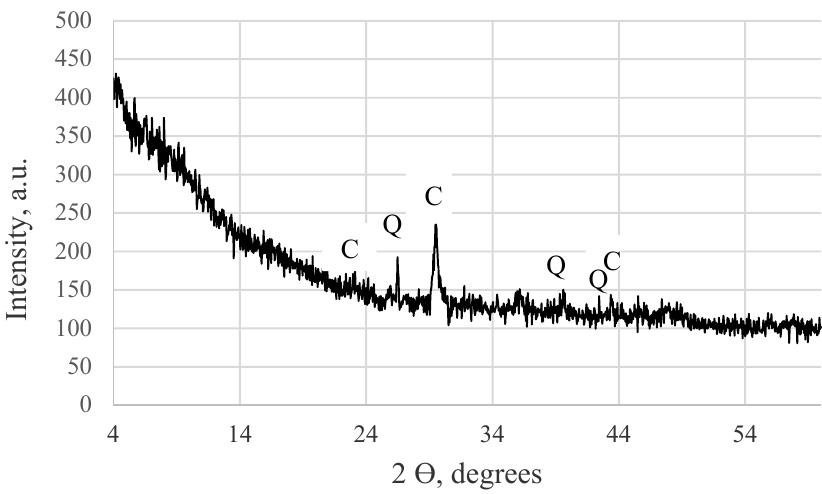
Figure 1. X-ray di ff raction patterns of tannery sludge: C—calcite, Q—quartz. Figure 1. X-ray diffraction patterns of tannery sludge: C—calcite, Q—quartz. Figure 1. X-ray diffraction patterns of tannery sludge: C—calcite, Q—quartz.